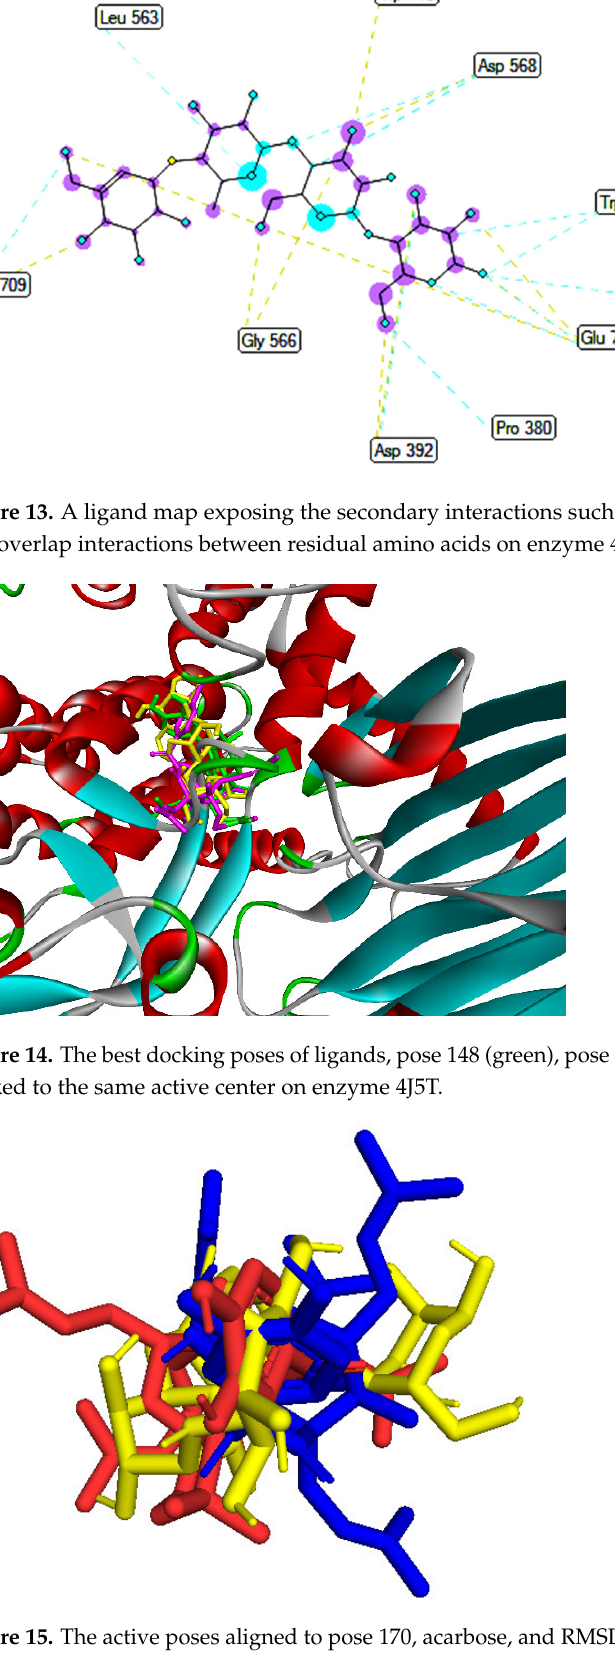
Figure 15. The active poses aligned to pose 170, acarbose, and RMSD calculated by PyMOL software.